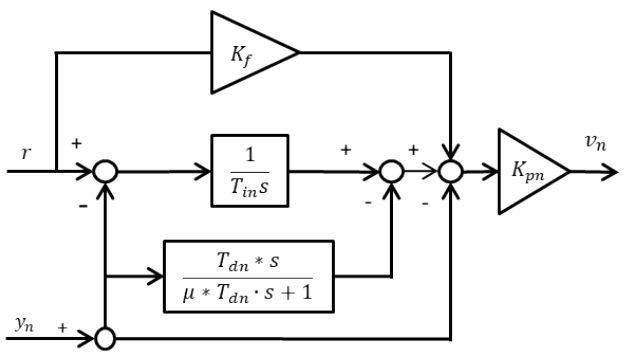
Figure 4. Block diagram of the integral-proportional-derivative (I-PD)